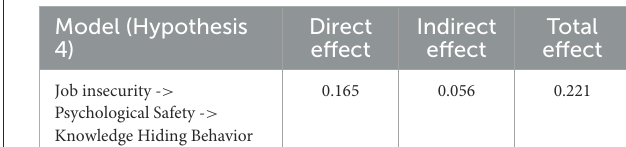
TABLE 4 Direct, indirect, and total effects of the final research model.